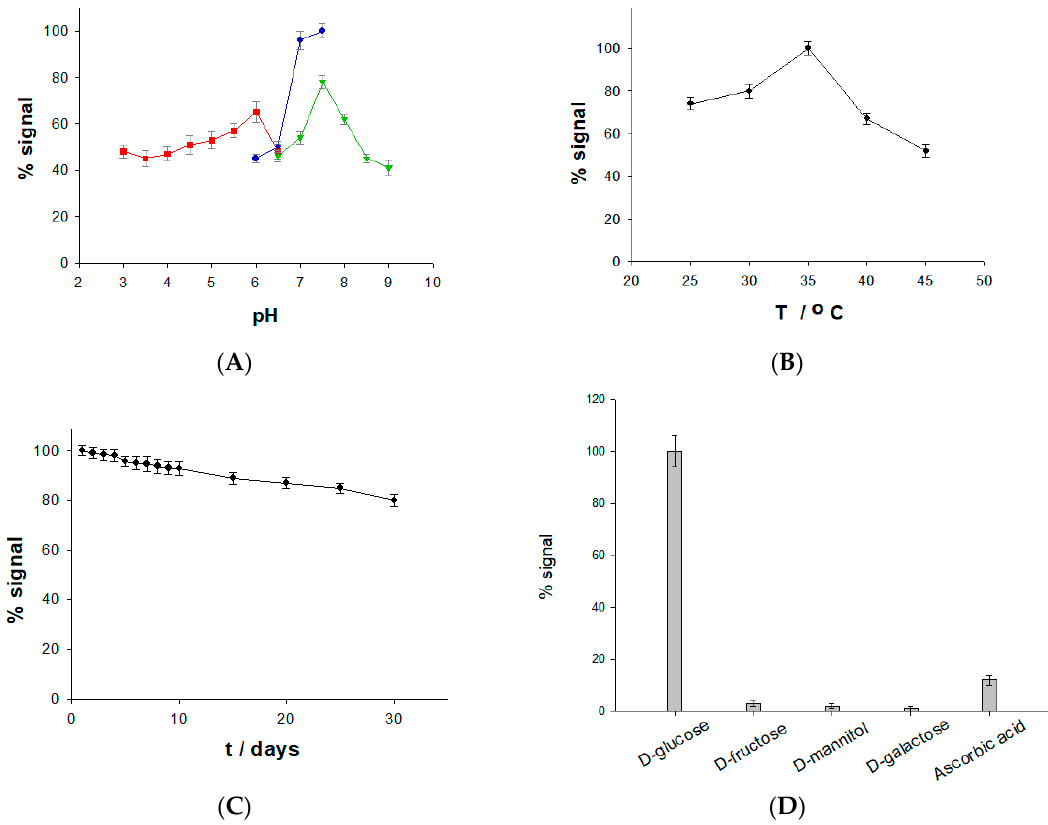
Figure 6. Effect of pH ( A ), temperature ( B ), stability ( C ), and the influence of interference ( D ) on the Au microneedles/h-PG/FcSH/FAD-GDH biosensor. Experimental conditions: ( A ) 0.1 M acetate buffer (red), 0.1 M phosphate buffer (blue), 0.1 M TRIS buffer (green), E° = 0.5 V versus SCE, 10 mM glucose; ( B ) and ( C ) phosphate buffer pH 7.5, E°= 0.5 V versus SCE, 10 mM glucose; ( D ) 20 μ M glucose, 20 μ M fructose, 20 μ M mannitol, 20 μ M galactose, 20 μ M ascorbic acid, phosphate buffer pH 7.5, E°= 0.5 V versus SCE.